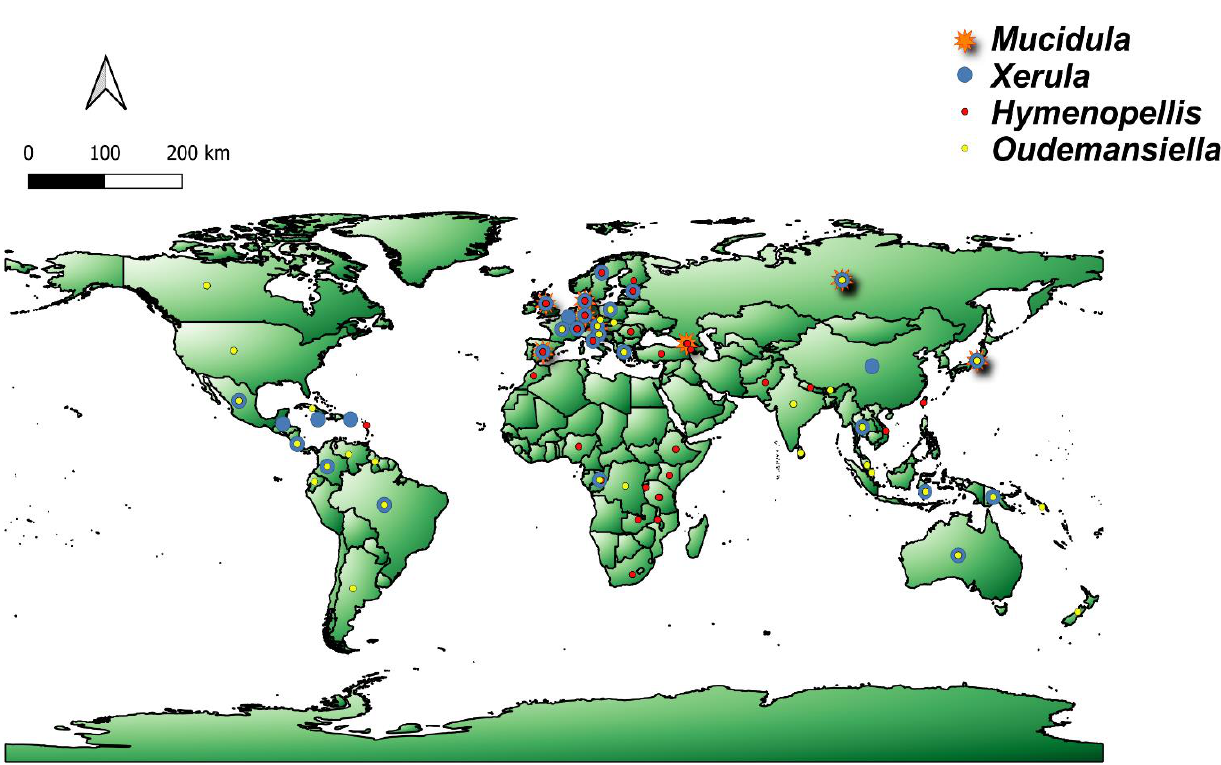
Figure 3. Geographical distribution of OX genera showing their concentration in some continents.